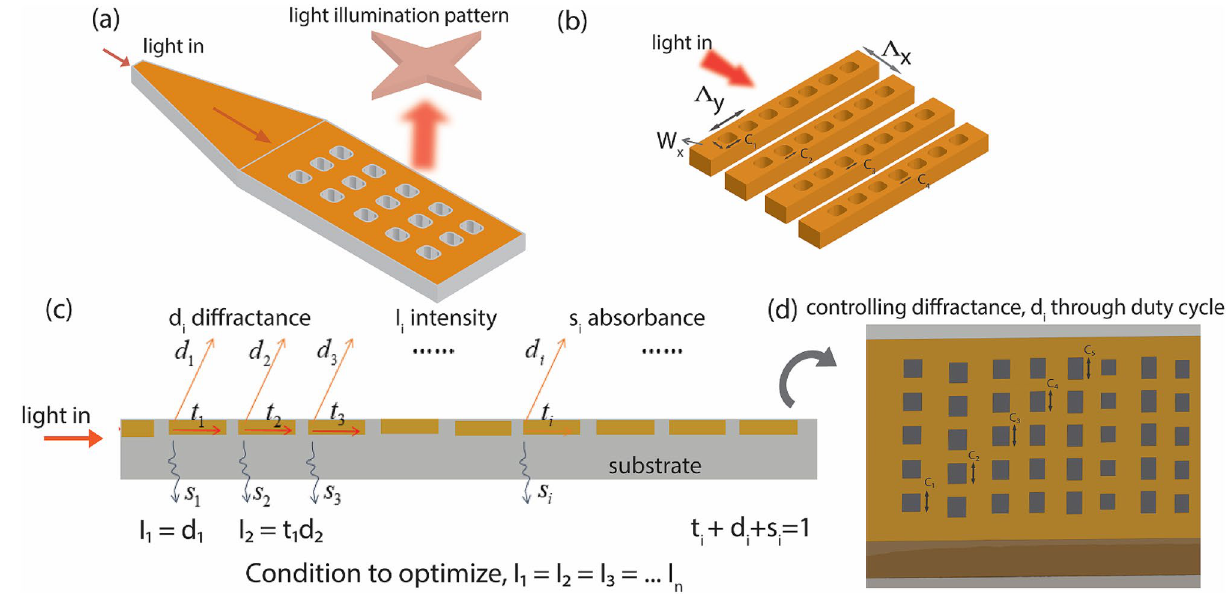
Figure 2. ( a ) Meta grating structure with rectangular scatterers in each grating row. ( b ) The rectangular scatterers are dispersed within a row and their characteristics are determined by the duty cycle (C) and their period ( (cid:31) x , (cid:31) y ). Each row has a different characteristic of rectangular scatterers that determine how much they diffract the light off the plane to illuminate the sample. ( c ) Light propagation in the metasurface is easily understood through an effective mirror model where the light gets diffraction ( d ), absorbed (s) and transmitted (t) through the individual row. Figure created in Adobe